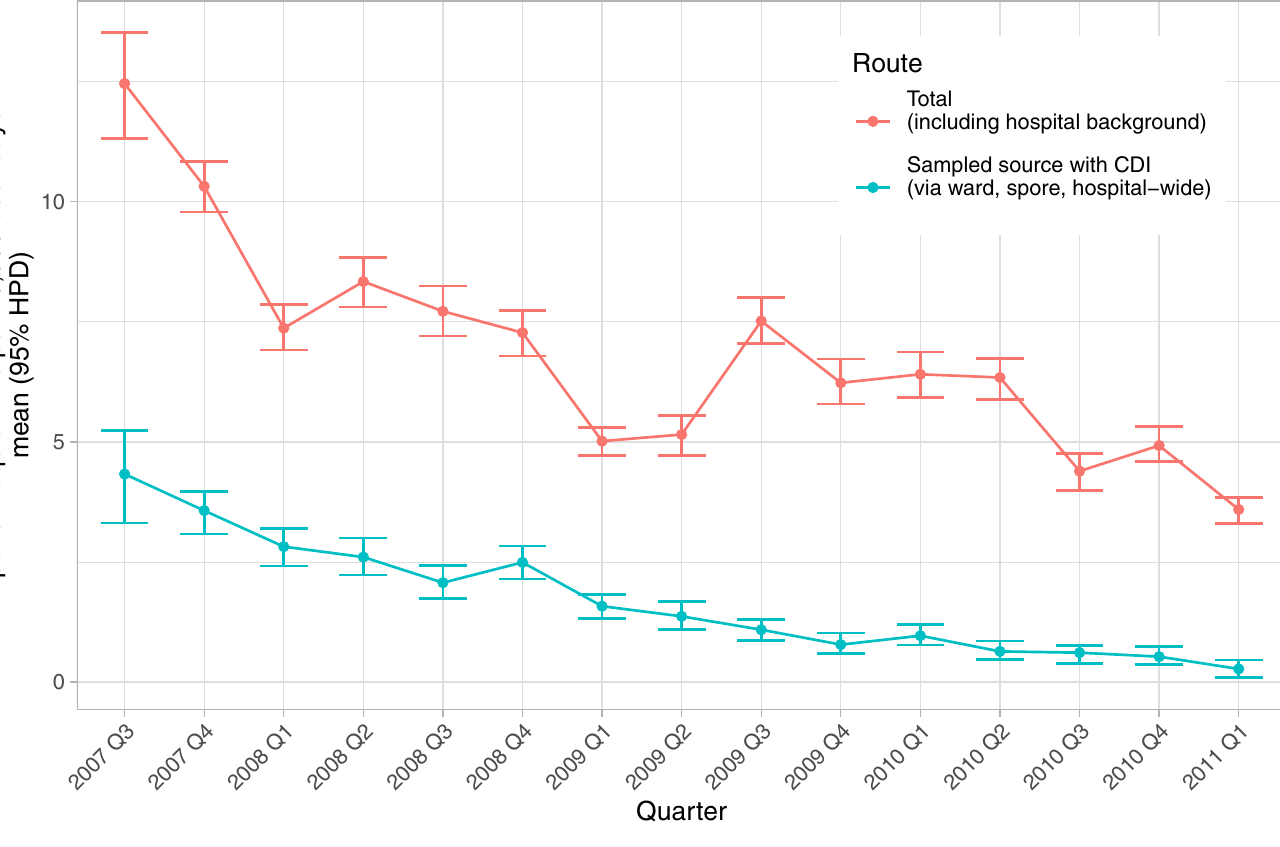
Fig 8. Temporal trends in C . difficile inpatient acquisition. Q, quarter; CDI, C . difficile infection.